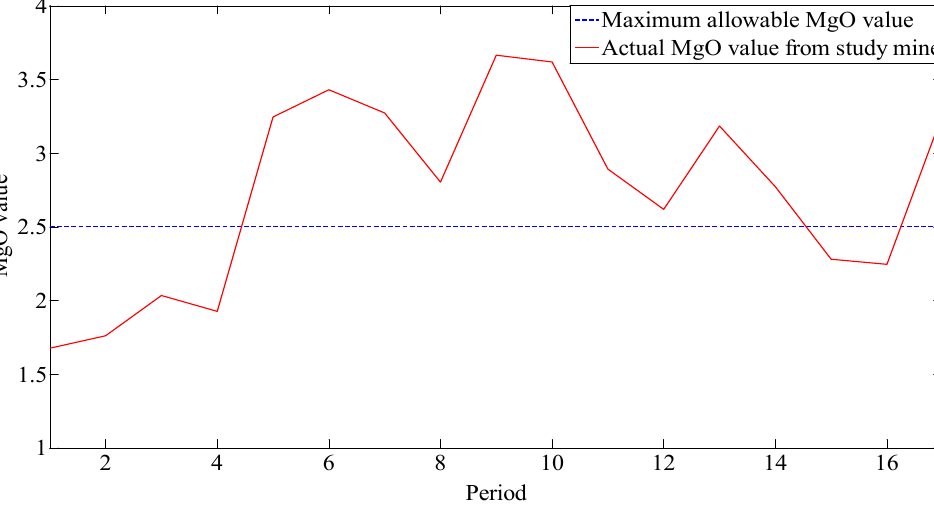
Figure 12. LSF value for Model 2 for 17 periods with LSF bounds for limestone from a nearby mine.